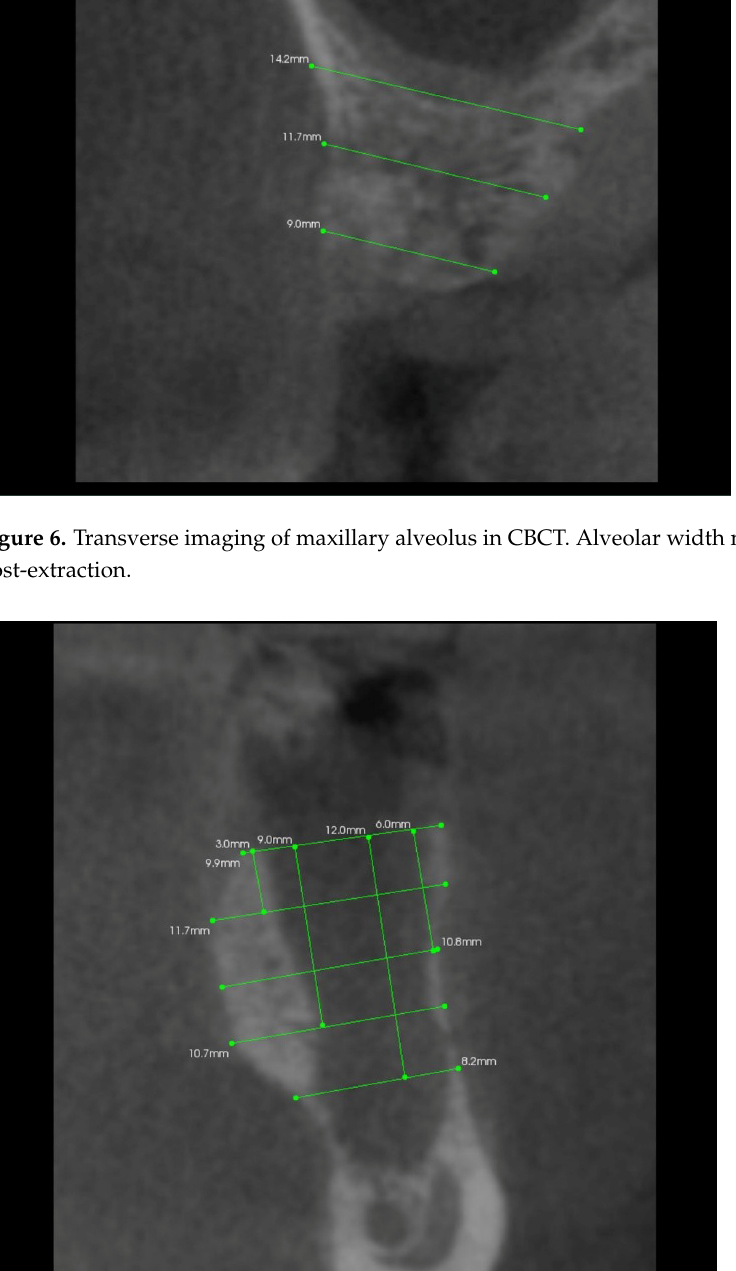
Figure 7. Transverse imaging of mandibular alveolus obtained from CBCT. The alveolus width measurement 10 days post-extraction.